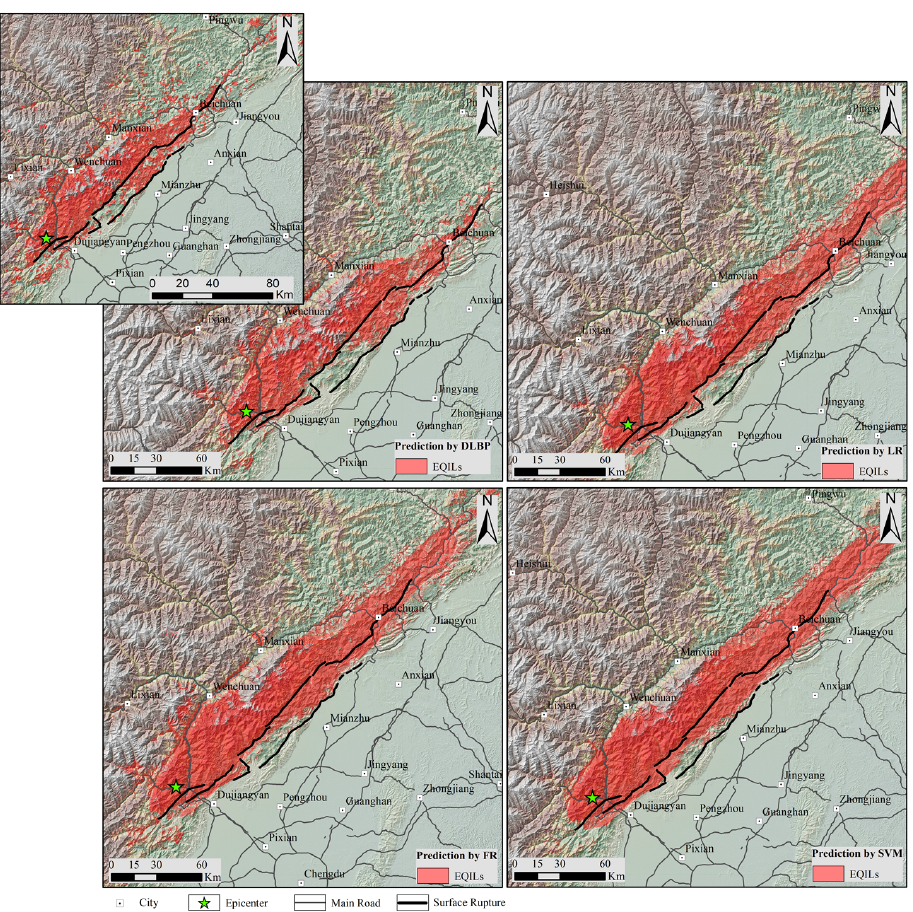
Figure 8. Spatial prediction of EQIL based on different methods.